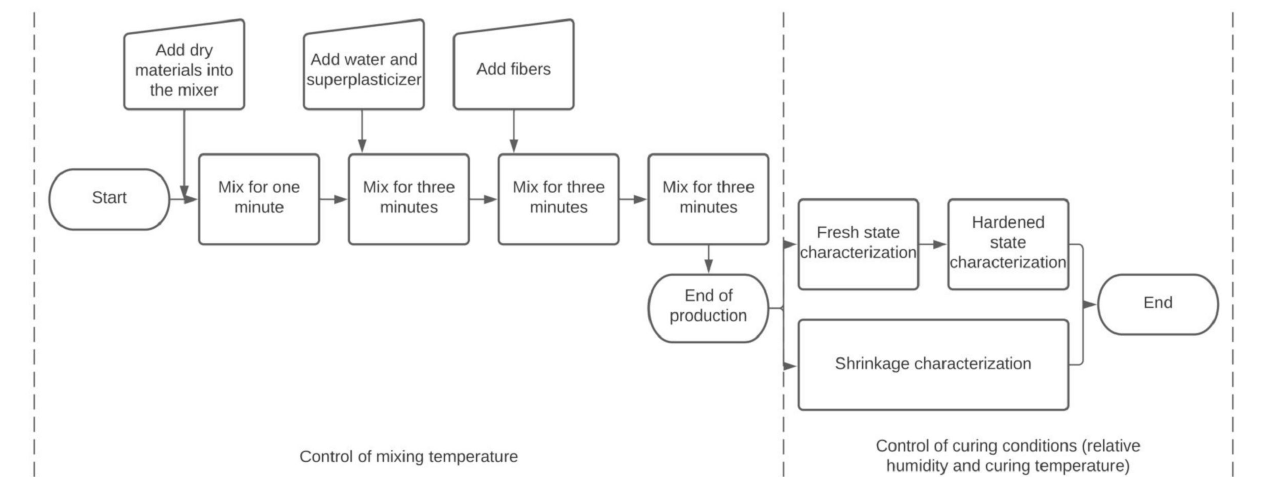
Figure 1. Sequences for the production and testing of the